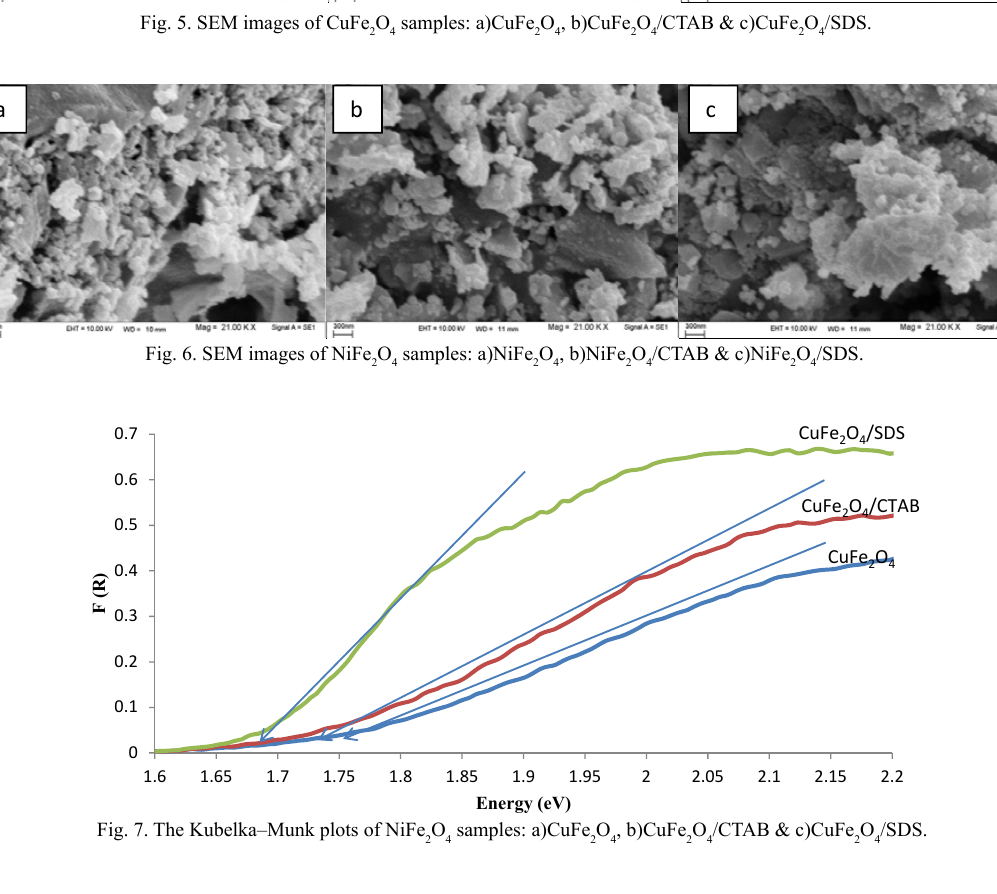
Fig. 5. SEM images of CuFe